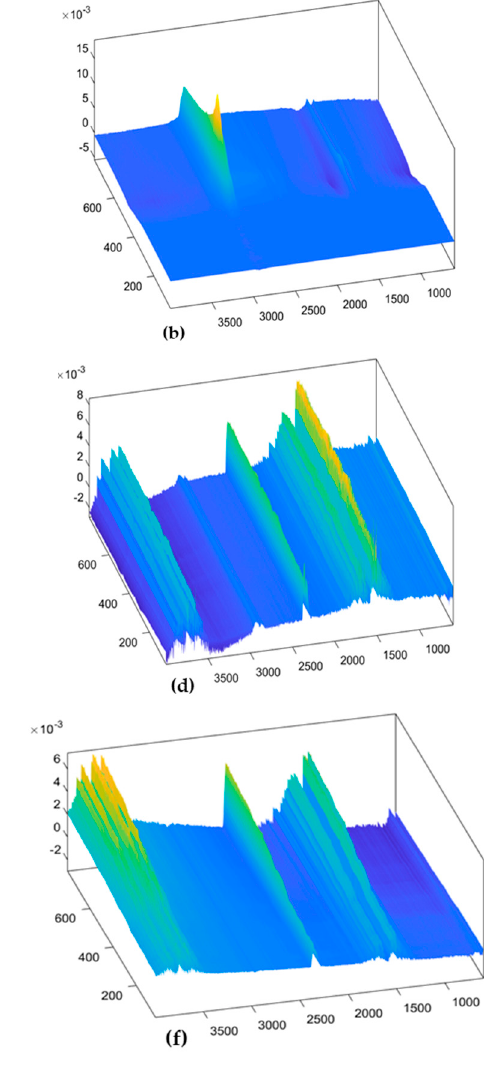
Figure 5. Loading surfaces of the three components of the PARAFAC models. ( a ) Component 1 of TGIS, ( b ) component 1 of TGO, ( c ) component 2 of TGIS, ( d ) component 2 of TGO, ( e ) component 3 of TGIS, and ( f ) component 3 of TGO. X-axis indicates wavenumber in cm − 1 , Y-axis indicates temperature in °C, Z-axis indicates component value.